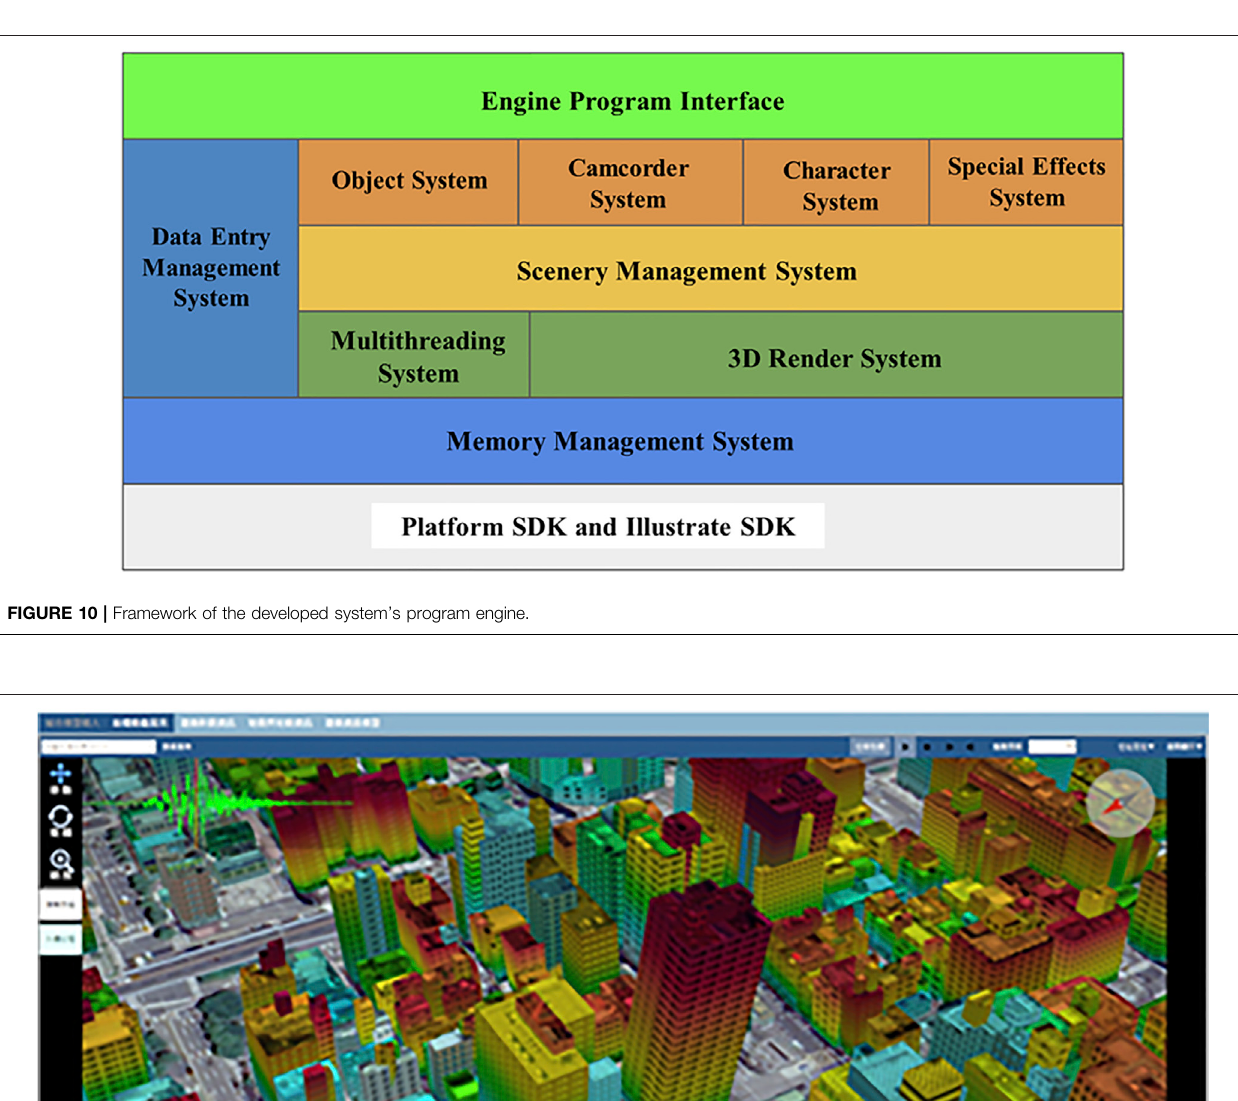
Frontiers in Built Environment |